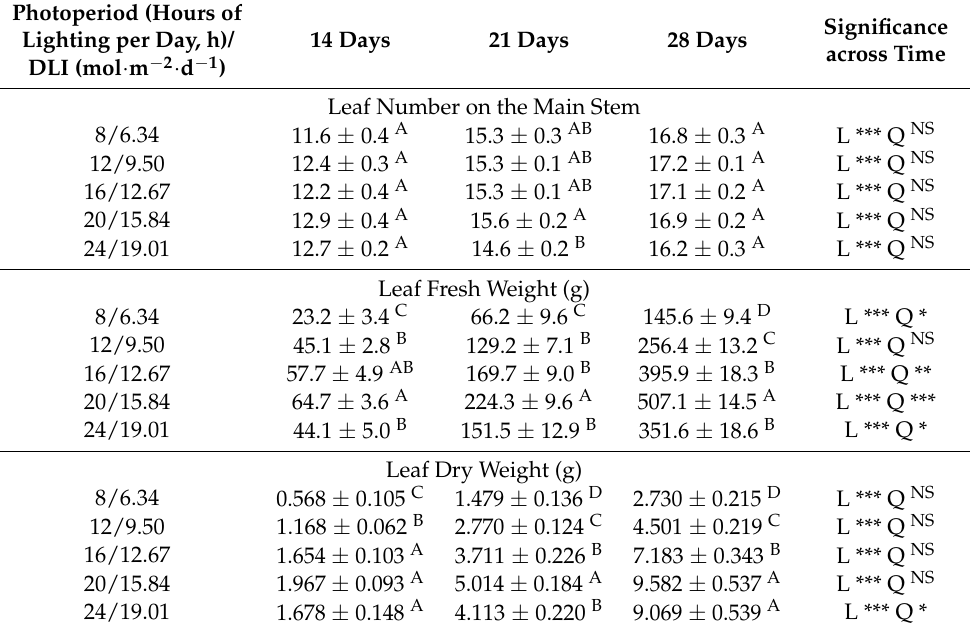
Table 3. Mean leaf number on the main stem, leaf fresh weight, and leaf dry weight of ice plant in response to photoperiod/daily light integral (DLI) treatment over time (plants harvested 14, 21, or 28 days after treatment). Data represent means ( ± SE) of 3 experimental units times 3 replications over time.